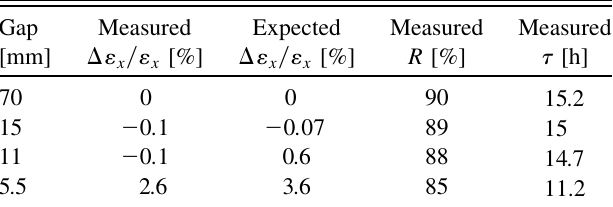
TABLE X. Variation of horizontal emittance " x , injection rate R , and beam lifetime (cid:14) versus gap.